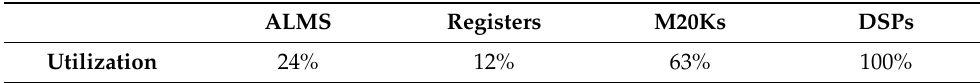
Table 2. Hardware resource utilization of Arria 10 Field Programmable Gate Array (FPGA).